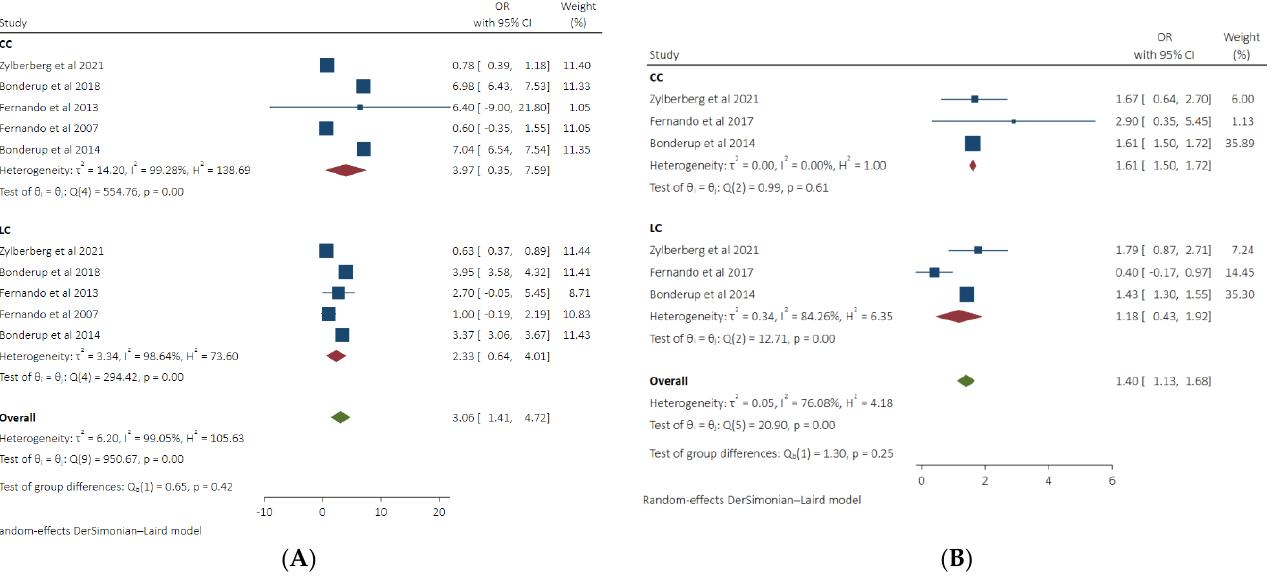
Figure 7. ( A ): Pooled odds of Lymphocytic and collagenous colitis in PPI users. ( B ): Pooled odds of Lymphocytic and collagenous colitis in NSAIDs users